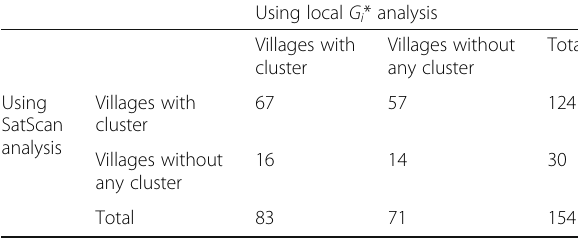
Table 3 Results of the sensitivity and specificity analysis